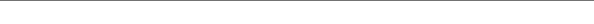
Table 1 | Protein array data from hearts of animals subjected to 3days of I/R.